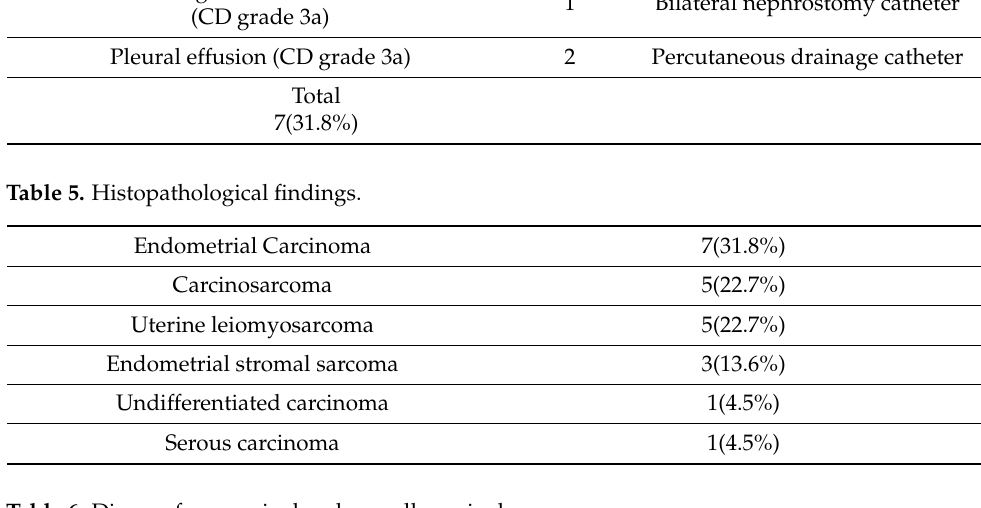
Table 6. Disease-free survival and overall